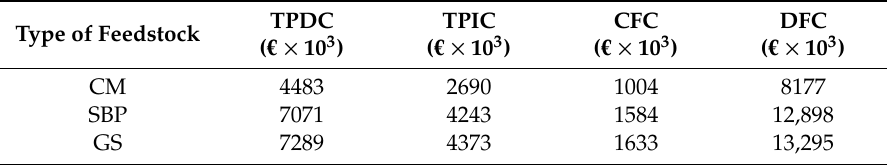
Table 11. Summary of fixed capital costs of biogas power